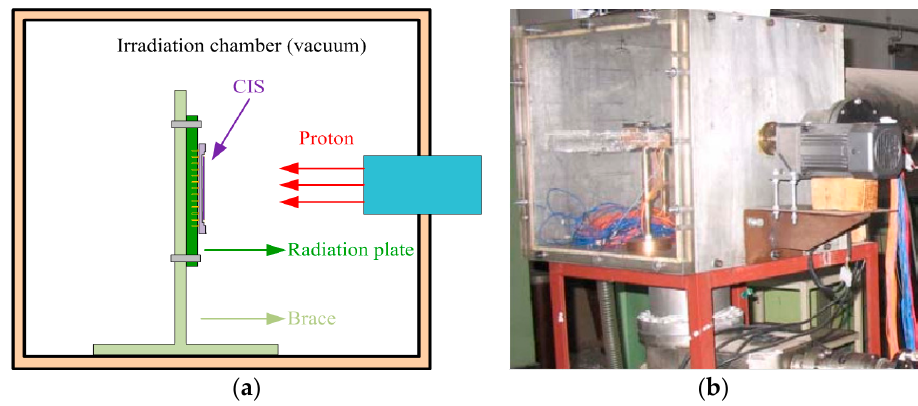
Figure 1. Experimental setup for the CIS proton radiation test: ( a ) schematic diagram of the experiment; and ( b ) photo of the irradiation chamber. Table 1. Proton radiation experiment conditions and samples.